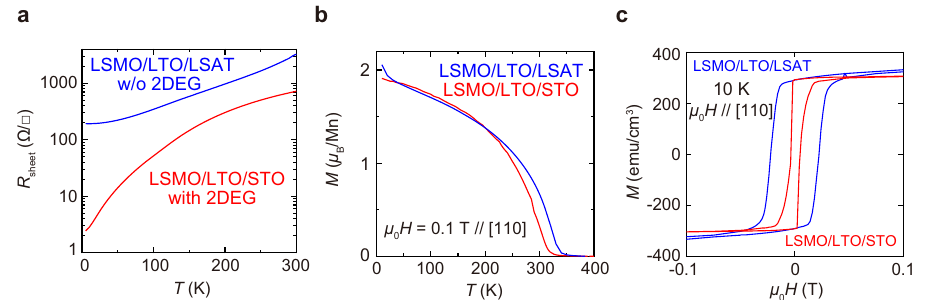
LSMO/LTO/LSAT are 320 and 340K, respectively. c Magnetization M for LSMO (30u.c.)/LTO (3u.c.)/STO and LSMO (30u.c.)/LTO (3u.c.)/LSAT measured at 10K as a function of a magnetic fi eld H applied along the [110] direction of the STO substrate.